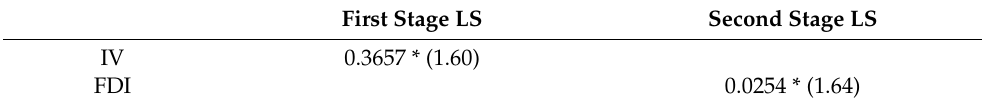
Table 5. The 2SLS estimation of the instrumental